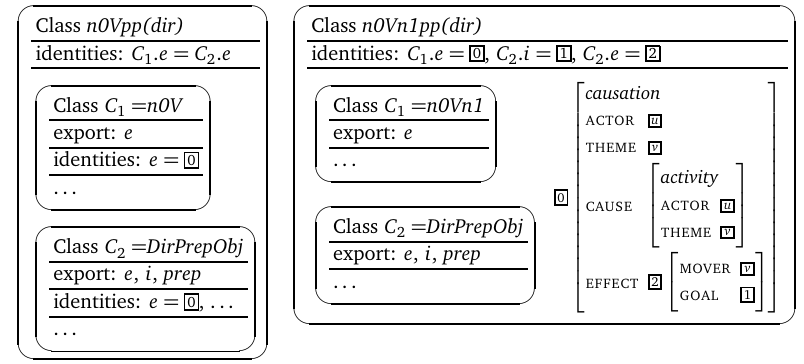
Figure 29: MG classes for directed motion